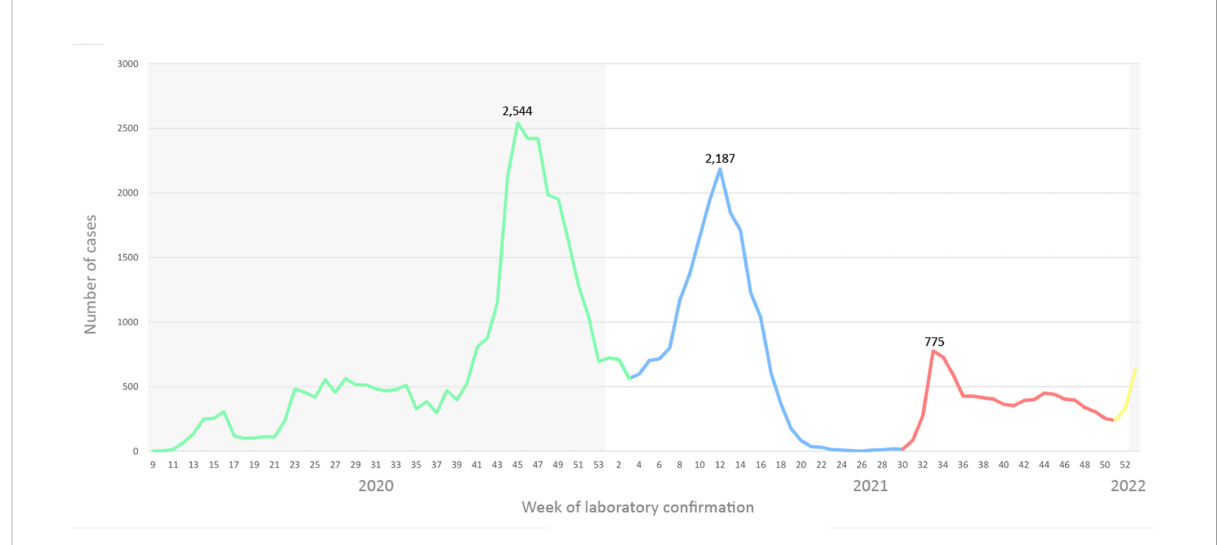
FIGURE 1 Number of SARS-CoV-2 cases on a weekly basis in a two-year span, color coded by variant. B.1 lineage designated with green, Alpha with blue, Delta with red and Omicron with yellow.